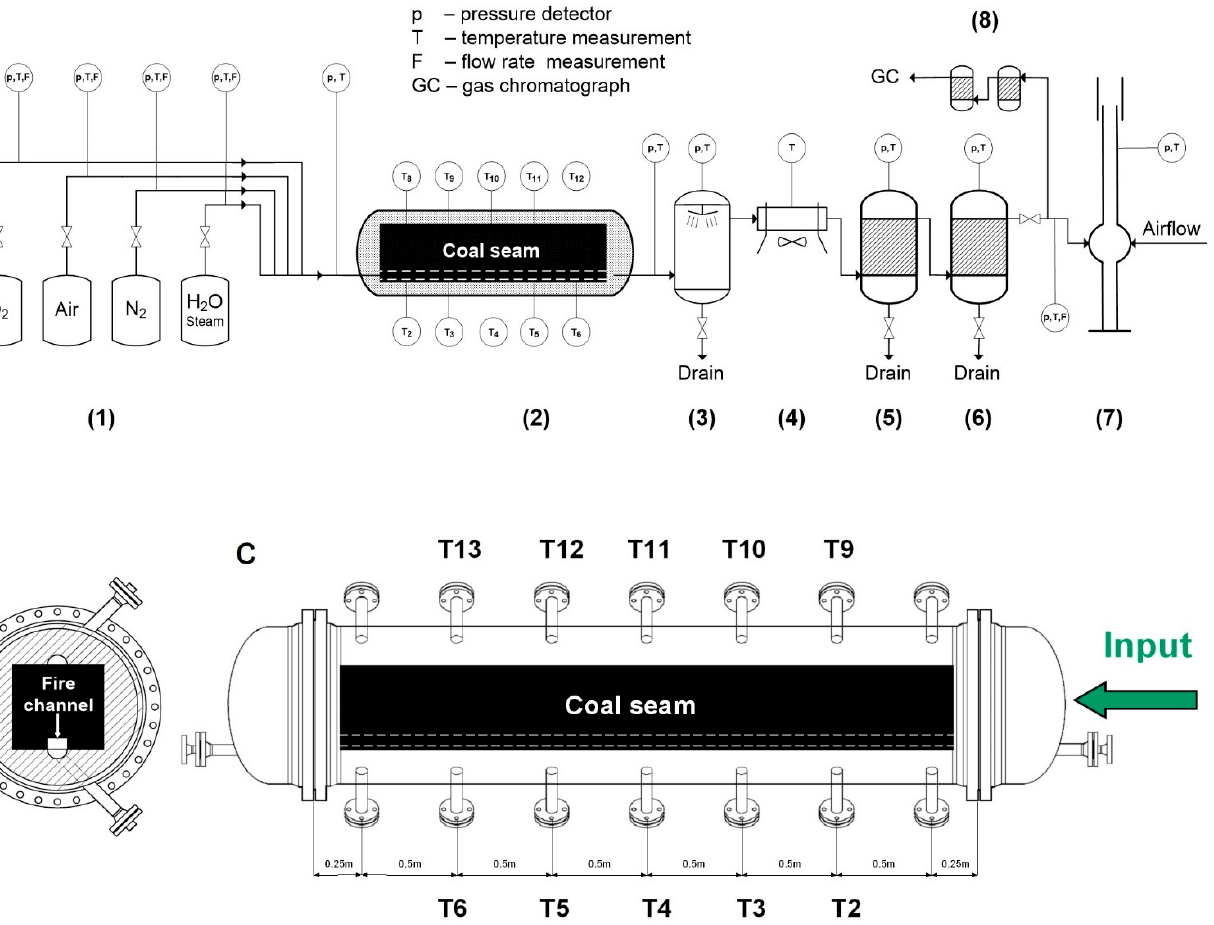
Figure 1. Reactor used in the experiment. ( a ) Scheme of the pressure unit for simulation of the underground coal gasification process, as follows: (1) compressed reagents, (2) pressure reactor, (3) wet scrubber, (4) air cooler, (5,6) gas cleaning system, (7) thermal combustor, (8) gas treatment module prior to GC analysis; ( b ) cross-section of the reactor, ( c ) longitudinal section of the reactor. The reactor was closed on both sides with cylindrical ends. Pipes passed